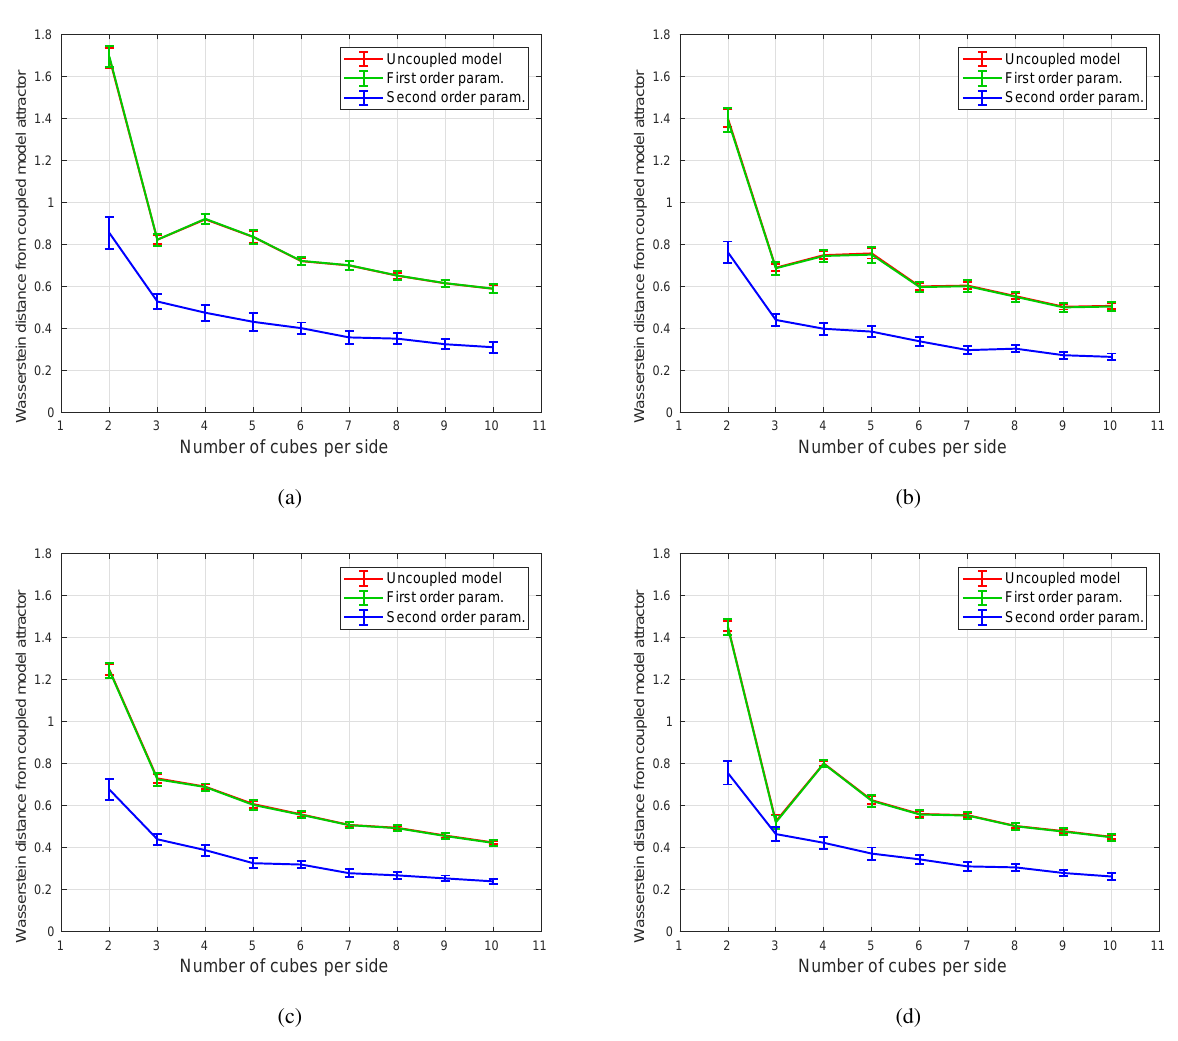
Figure 9. Wasserstein distances from the coupled model with respect to number of cubes per side: (a) 3-D case, (b) projection on XY plane, (c) projection on XZ plane, and (d) projection on YZ plane. For case τ = 1